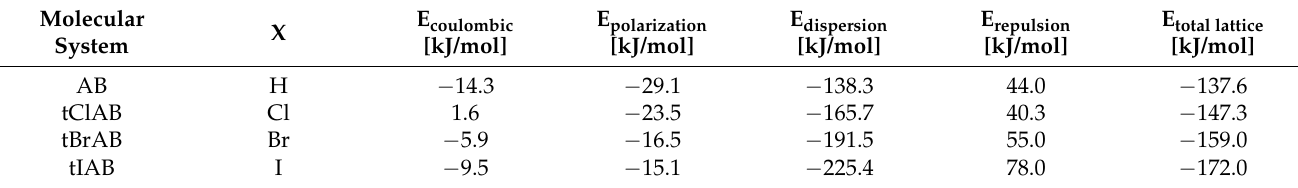
Table 2. Separation of coulombic/polarization/dispersion/repulsion terms to the total lattice calculated within CLP.